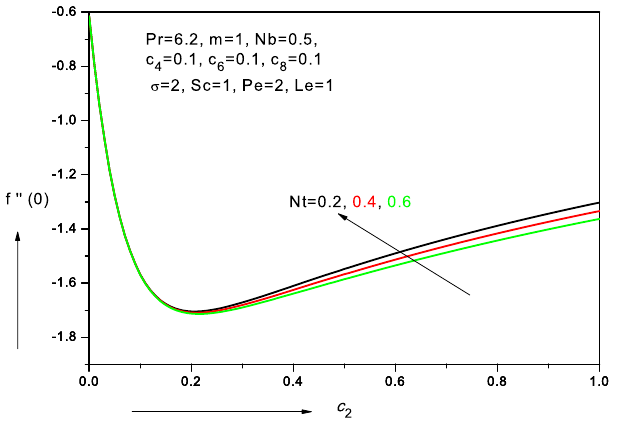
Figure 14. Variation of reduced skin friction coefficient with viscosity parameter ( c 2 ) in water-based nanofluid.